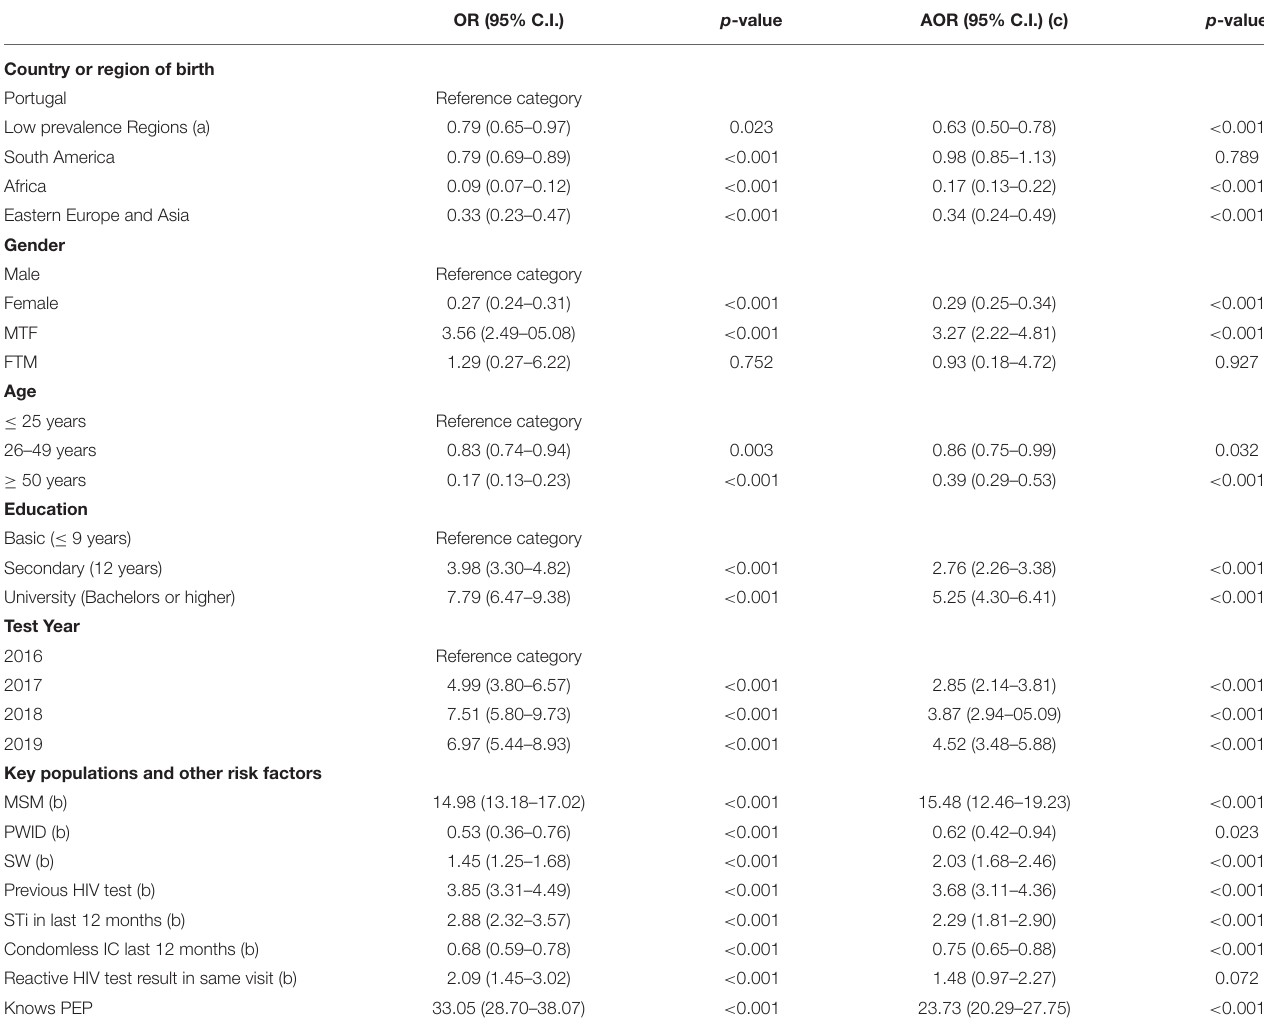
TABLE 5 | Factors associated with knowledge of